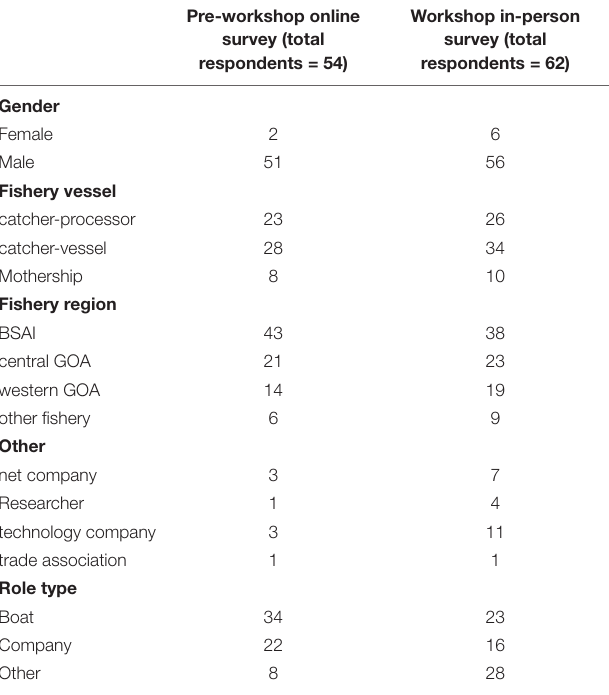
TABLE 2 | Respondent demographics and fishery/industry groups for the pre-workshop online survey and during the in-person workshop. Pre-workshop online survey